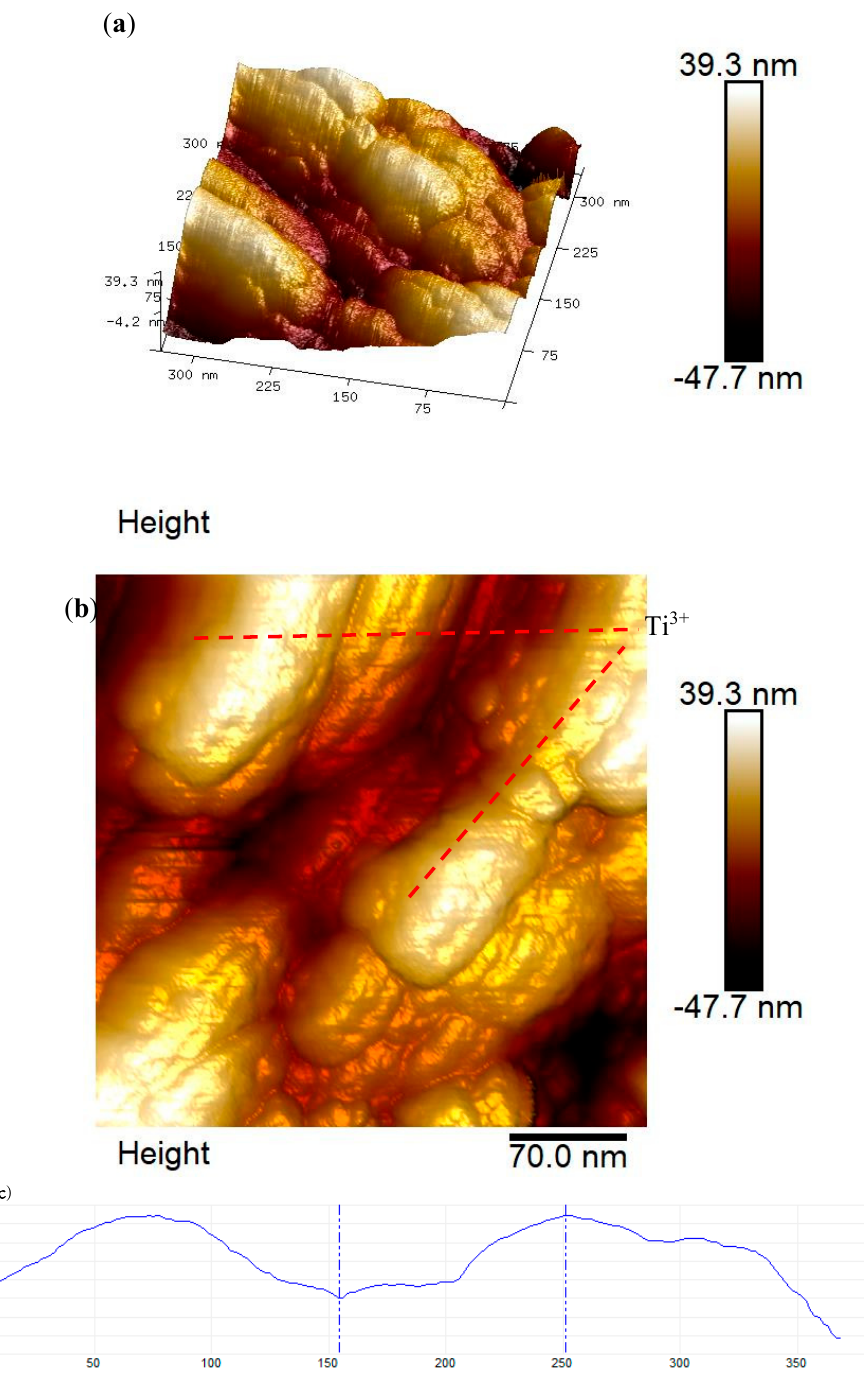
Figure 6. AFM images of 120 ◦ C sputtered of rGO-TiO 2 nanocomposite for ( a ) 3D orientation, ( b ) particular focus area, and ( c ) cross-section data.